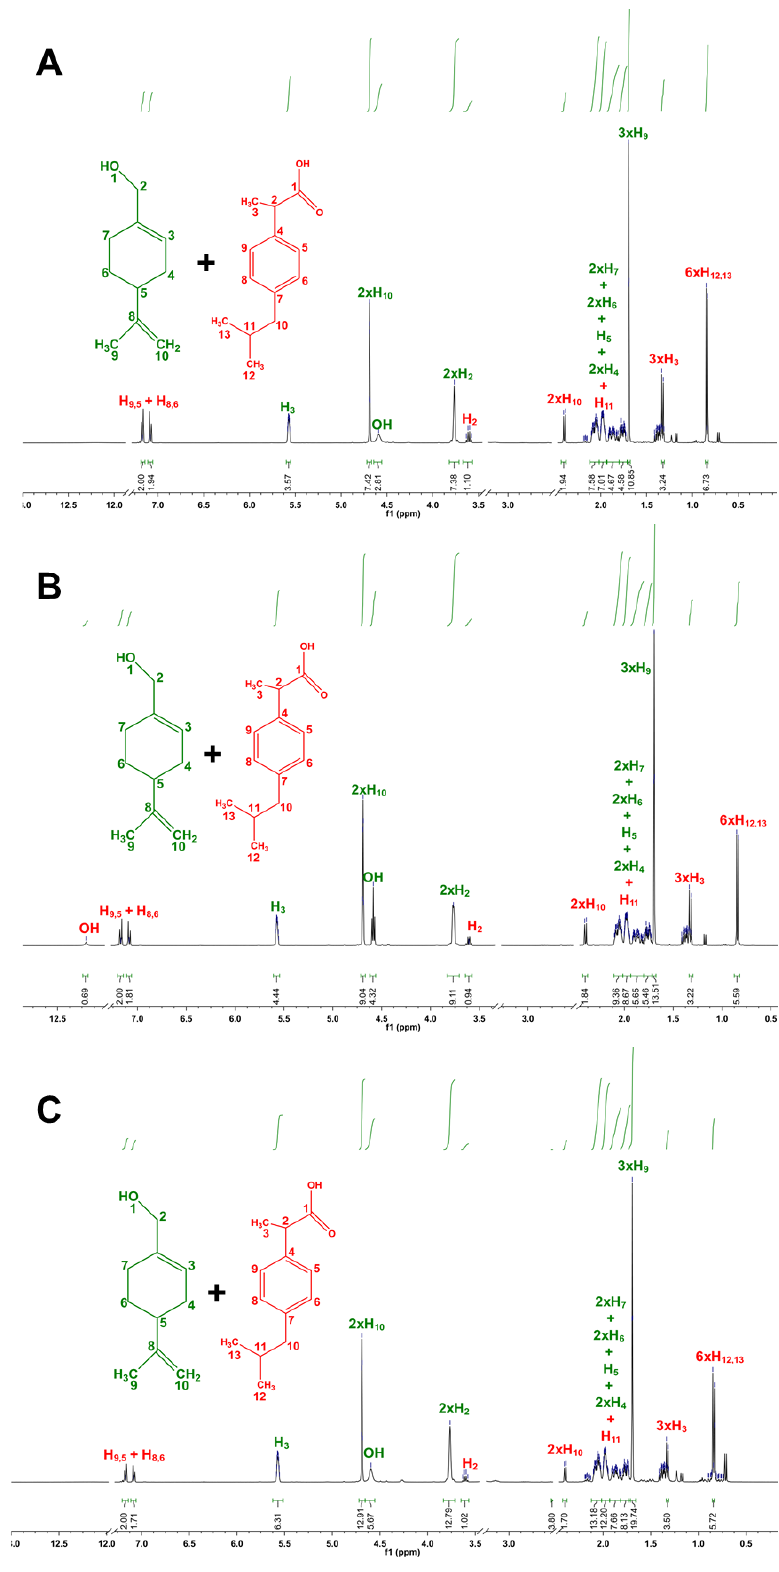
Figure 4. 1H NMR spectra of THEDES: ( A ) POH:IBU 4:1, ( B ) POH:IBU 6:1 and ( C ) POH:IBU 8:1. Peak assignment and integration were fully performed.